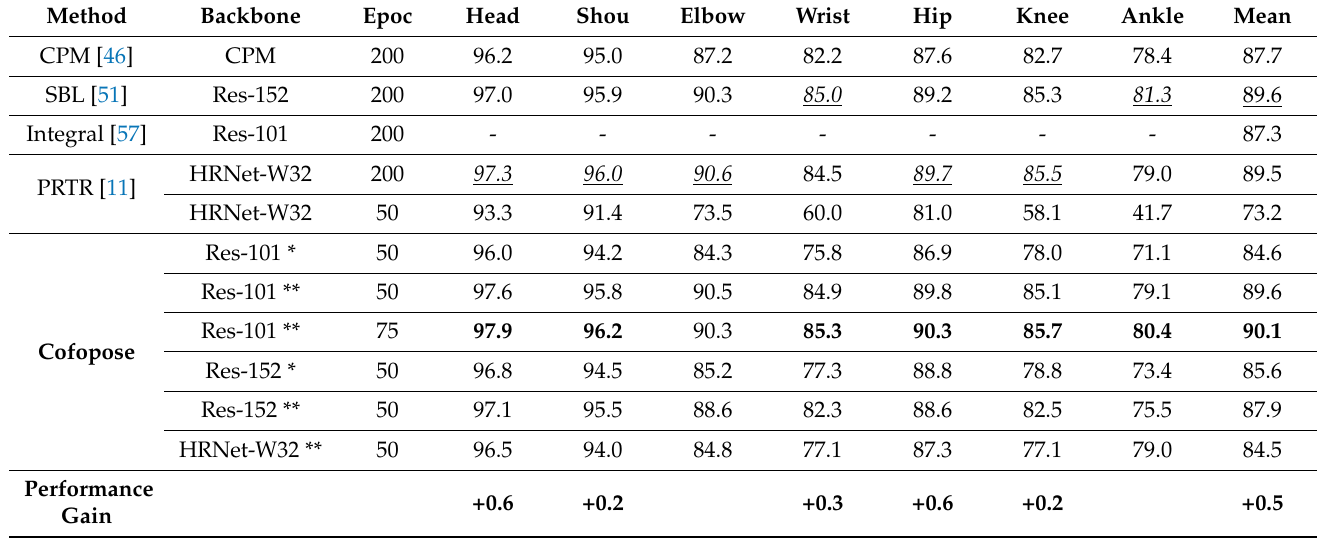
Table 2. Comparisons on the MPII validation set (PCKh @0.5). Results for lower and higher resolu- tions with different backbones. We use * to denote Cofopose with lower resolution and ** for higher resolution, with 256 × 256 and 512 × 512,